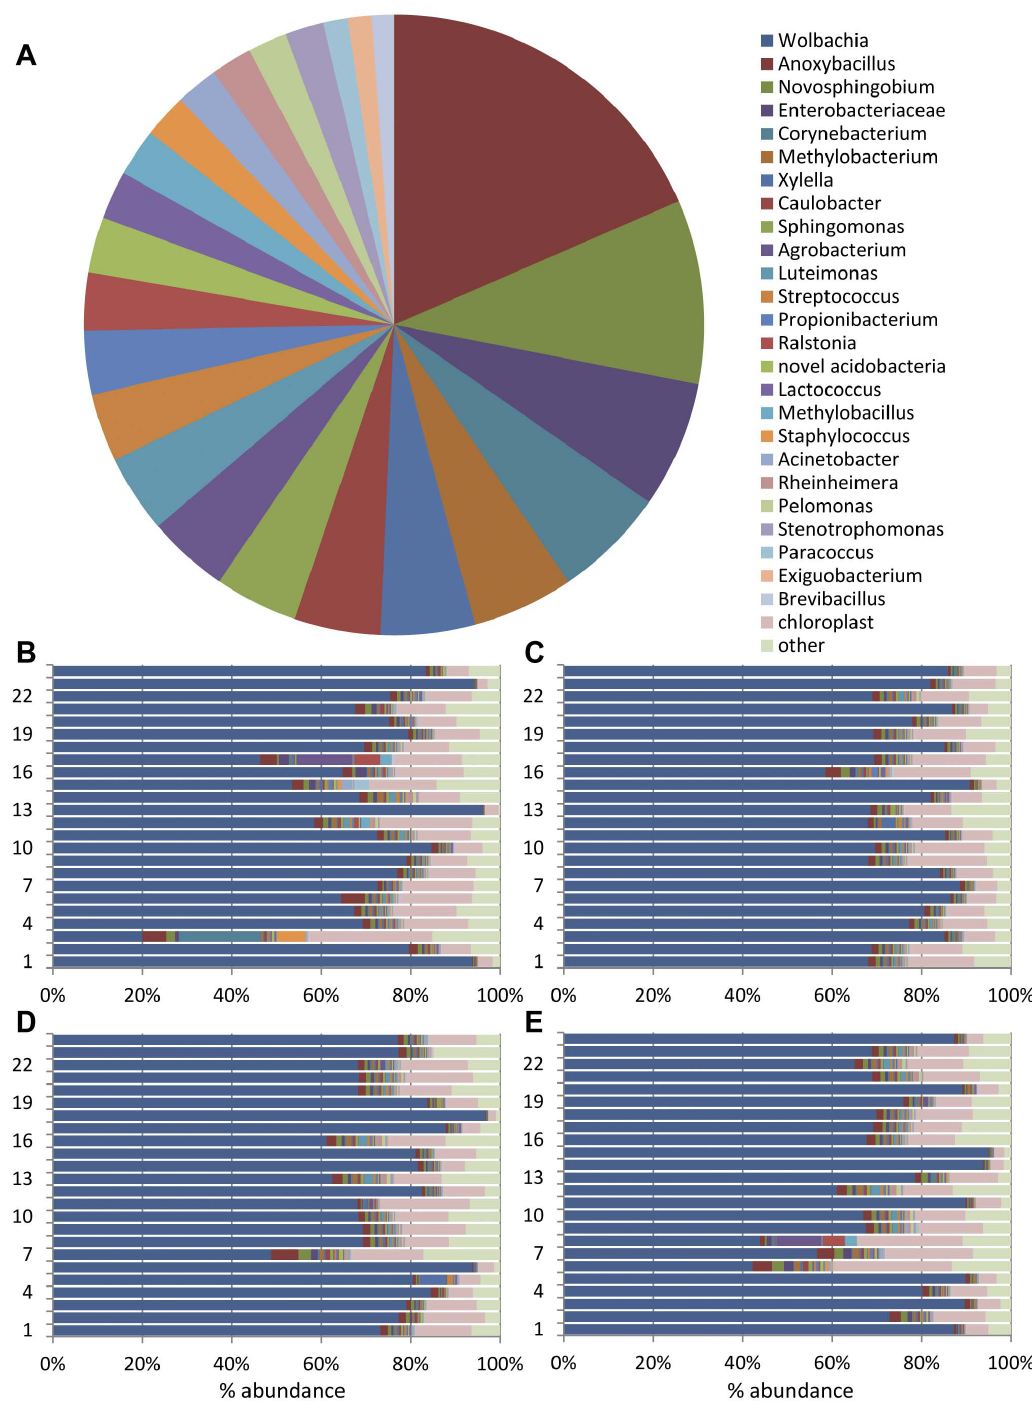
Figure 1. Genera most commonly associated with H.vitripennis cibarium and precibarium. A) Average abundance of non- Wolbachia genera over all 96 insects; B–E) Abundance of all classifications from B) Bakersfield individuals; C) Ojai individuals; D) Florida individuals; E) colony individuals. Color legend in panel A applies to all panels (A–E); order of classifications in the legend is the same as the order around the pie graph in A (starting with the dark red Anoxybacillus in the upper right) and in the bar graphs B–E (starting with the dark blue Wolbachia on the left). been used to further characterize Wolbachia strains [15]. Sequences from the three California insect sources (Bakersfield, The 16S rRNA gene shows little to no divergence in many Ojai, and the colony, which was originally collected in Bakersfield) strains of Wolbachia isolated from disparate insect hosts and were identical and are grouped together in Table 3. However, geographic locations. MLST (multilocus sequence typing) analysis